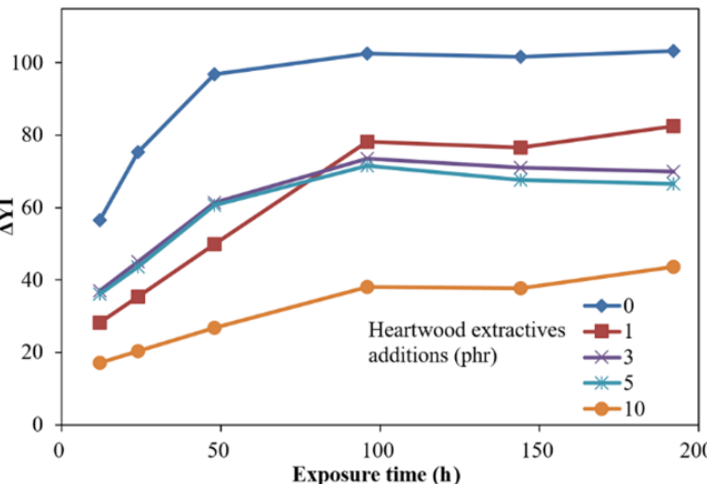
Figure 3. Time-dependent yellowness difference ( Δ YI) of ROL films with various A. confusa heart- wood extractive additions after UV irradiation.